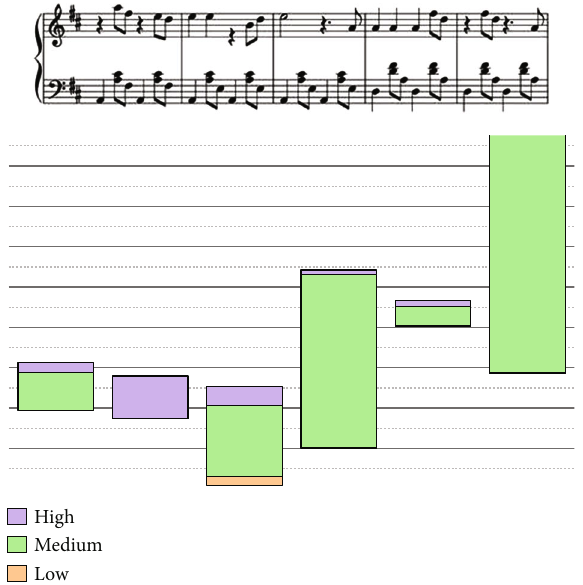
Figure 4: Changes in tune memory and